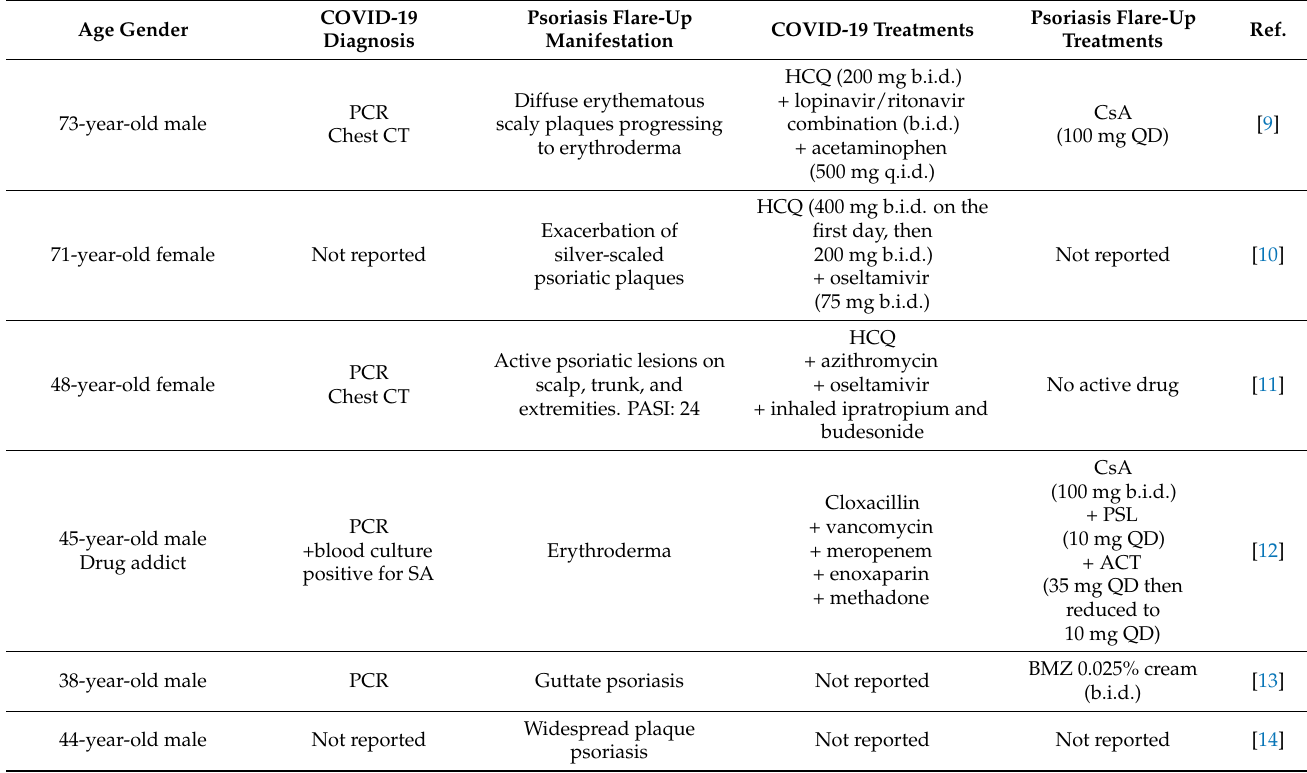
Table 1. A summary of cases reporting psoriasis exacerbation following anti-SARS-CoV-2 infection. Age